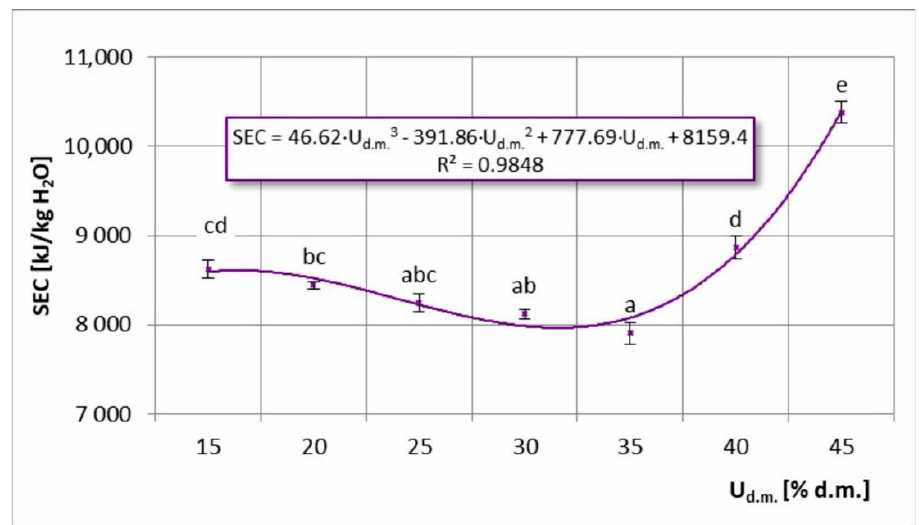
Figure 7. Specific energy consumption (SEC) in the process of spray drying chokeberry juice at dif- ferent inlet air temperatures (T); (a, b, c, d — different letters show significant differences between mean values ( p ≤ 0.05)).